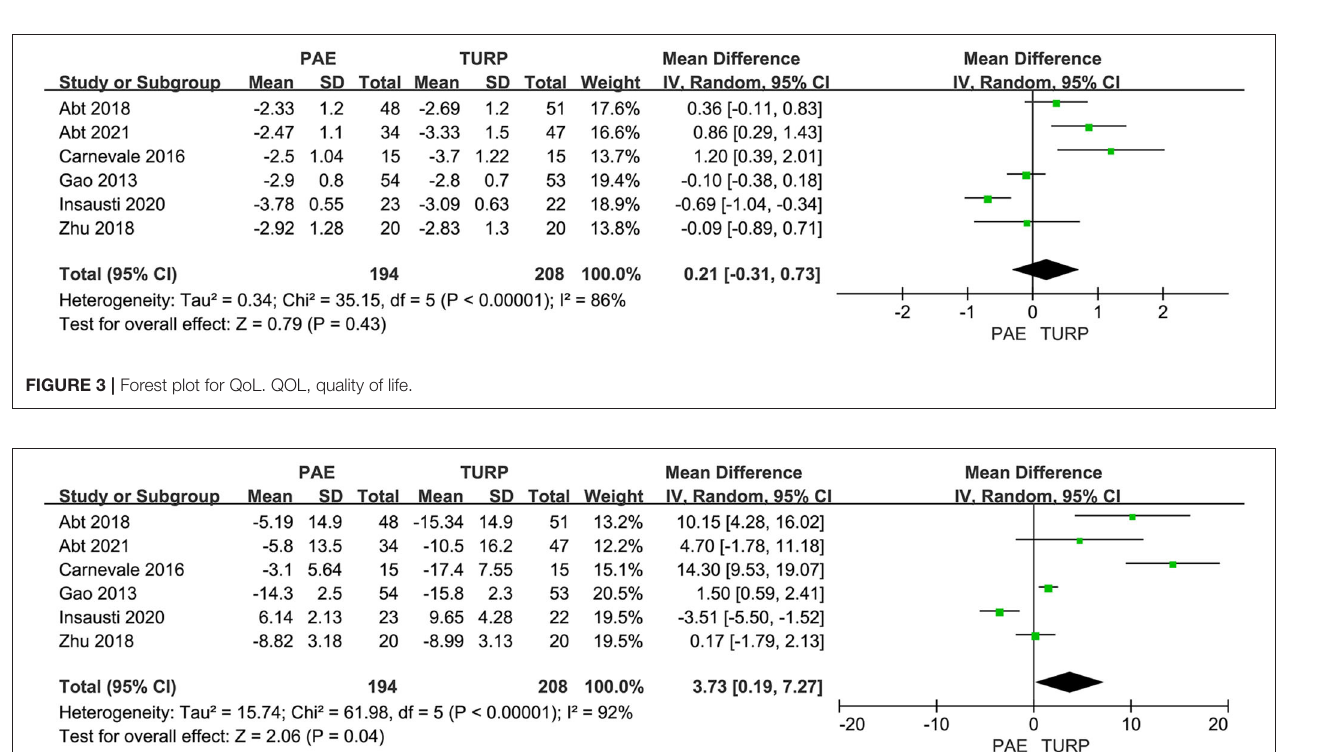
FIGURE 2 | Forest plot for IPSS. IPSS, International Prostate Symptoms Score.